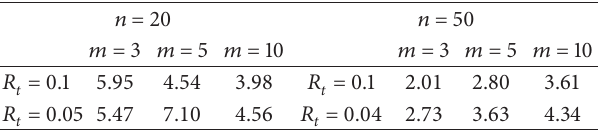
Table 8: Comparing IS2 with the MGS